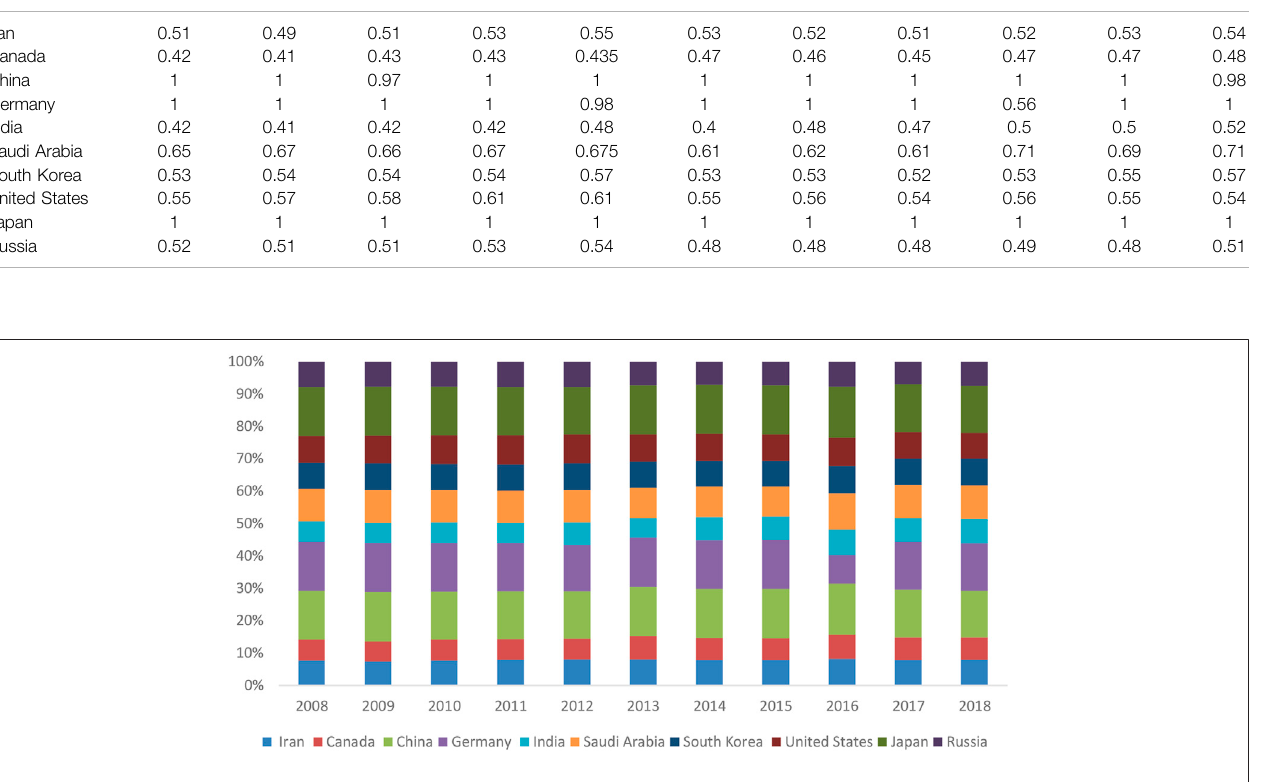
FIGURE 1 | Energy ef fi ciency score.